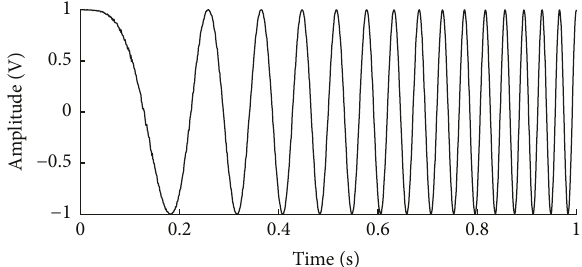
Figure 7: A typical form of an excitation signal used during experimental measurements.